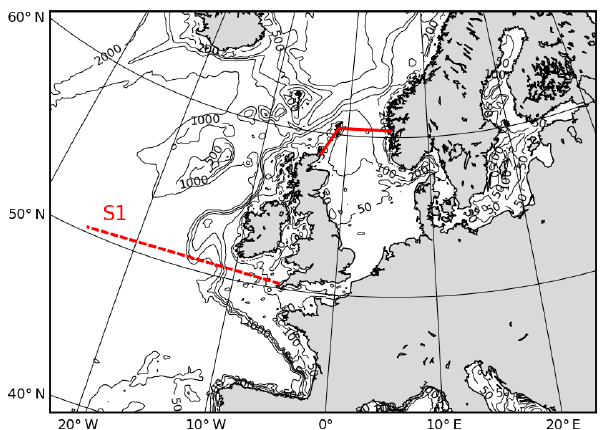
Figure 4. Bathymetry of NWES region. S1: transect used to il- lustrate changes in the vertical nutrient distribution near the shelf break. Solid red line: northern boundary of the area used to calcu- late budgets for the northern North Sea. The southern boundary is the 50m